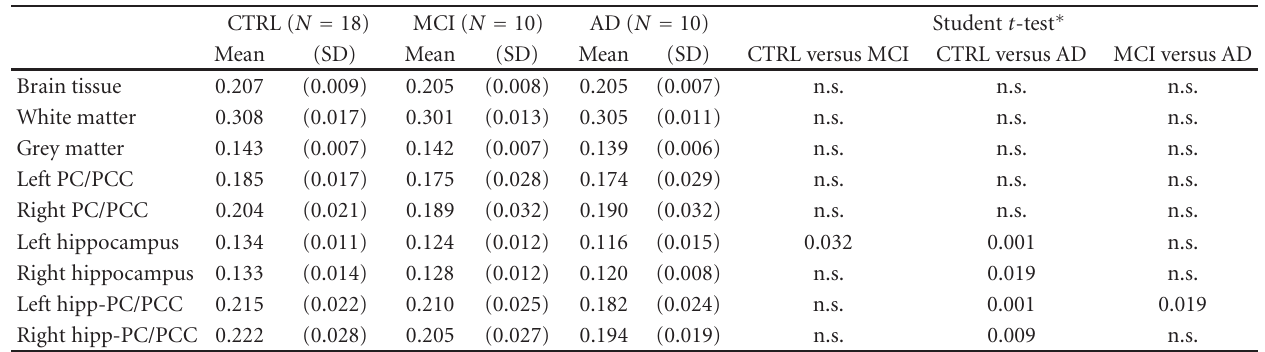
Table 4: Fractional anisotropy in CTRL, MCI, and AD